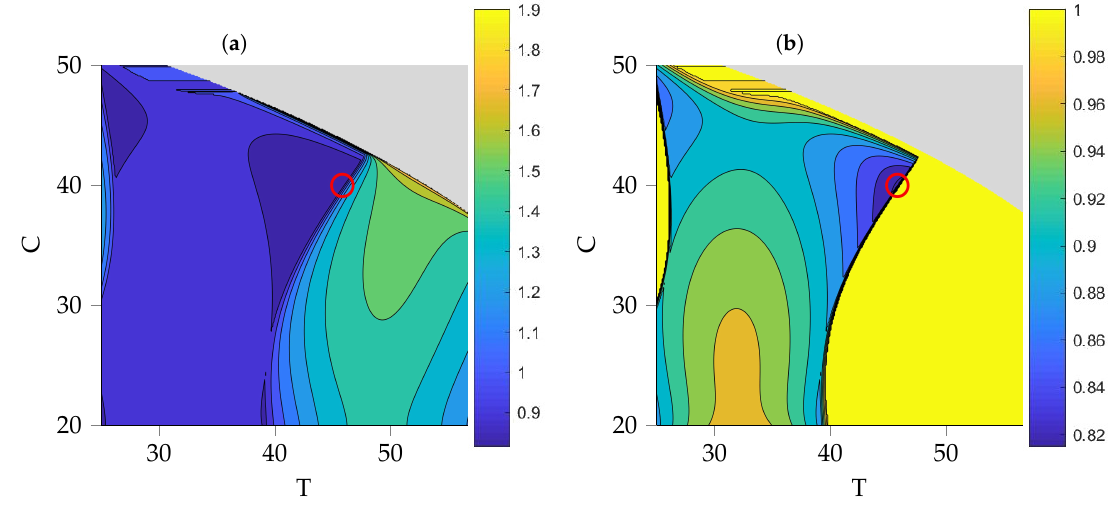
Figure 5. Objective function L over process parameters T and C . ( a ) Global view. ( b ) Local view with adapted color index to visualize differences in the area of minima. Red circle indicates minimum of L ( ξ ) with ˆ T = 45.8 ◦ C and ˆ C = 40m M . No value can be obtained for the process parameters in the grey area due to a nucleation rate value of d = 0 and an initial condition of zero particles.